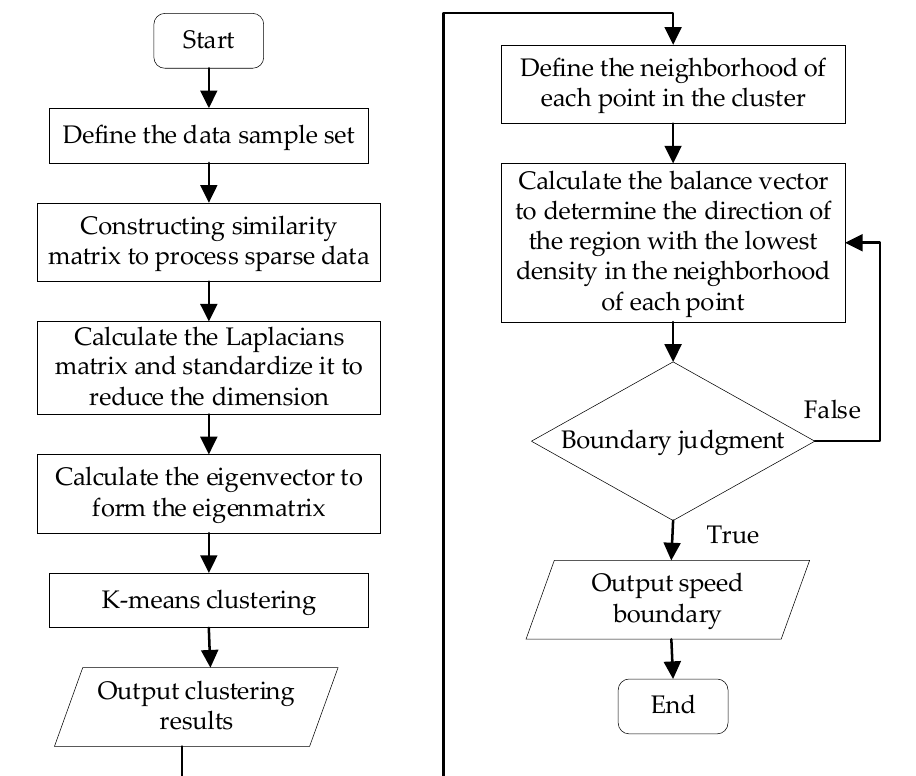
Figure 2. Flow chart of the method for extracting the catastrophe boundary of speed.